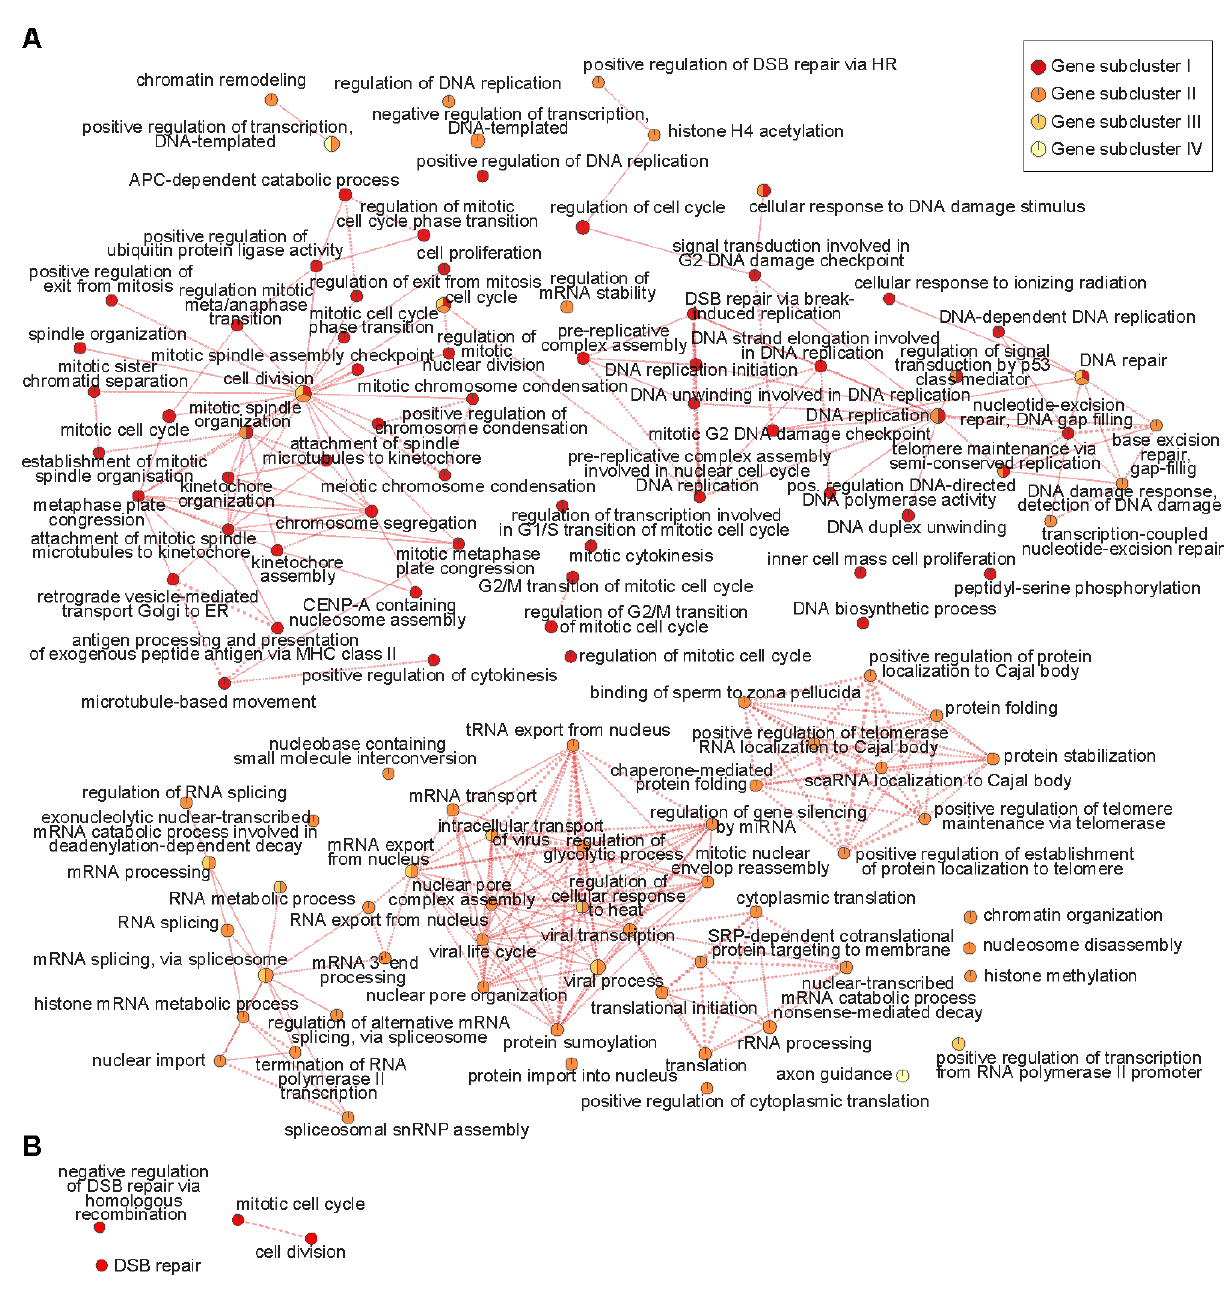
Figure 2. Enrichment for DNA replication, repair, and mitosis-related processes in gene subclusters that show comparable gene expression patterns between medulloblastoma patients and E15-P7 CGNPs. ( A ) Gene ontological analysis showing enriched biological processes in gene subclusters I-IV that exhibit comparable gene expression patterns in E15-P7 CGNPs (orange group) and SHH medulloblastomas (see also Figure 1D,F). Each node represents a biological process. Biological processes connected by edges have genes in common. Enriched biological processes were determined with the Database of Annotation, Visualization and Integrated Discovery (DAVID), v.6.8 (Benjamini-corrected q = 0.1, p = 0.01) and visualized with the Enrichment Map app in Cytoscape. Red nodes: enriched in gene subcluster I of Figure 1F; dark orange nodes: enriched in gene subcluster II; light orange nodes: enriched in gene subcluster III; yellow nodes: enriched in gene subcluster IV. ( B ) Gene ontological analysis showing enriched biological processes in gene subclusters I-IV that exhibit compared gene expression patterns in P0-P7 CGNPs (red group) and SHH medulloblastomas (see also Figure